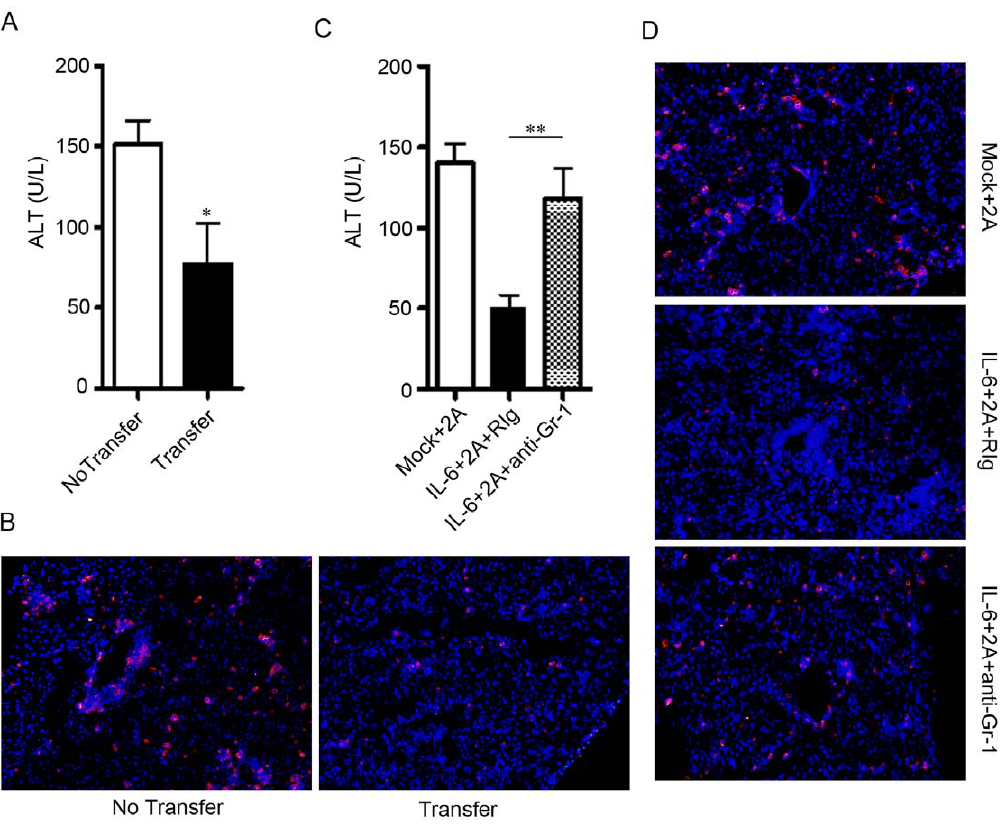
Figure 5. Gr-1 + CD11b + myeloid cells mediate the liver protective effect of IL-6. (A) C57BL/6 mice were i.p. injected with 100 m g 2A at day 0, and then adoptively transferred with 1 6 10 7 CD11b + intrahepatic leukocytes from IL-6 treated mice or PBS as control at day 5. ALT levels in serum were detected at day 10. CD11b + cells purification procedure was described in Materials and Methods . Representative data from 2 independent experiments with at least 3 mice per group was shown. (B) Detection of CD8 + T cells (red color) in liver sections. Mice were treated as in (A). DAPI counterstaining was used to detect nuclei. (C) C57BL/6 mice were hydrodynamic injected with pcDNA-IL6 plasmid or mock plasmid at day 0. At day 2, they were i.p. injected with 2A antibody. 300 m g of anti-Gr-1 antibody or control Rat IgG were given at day 2, 4, 6, 9, and ALT levels in serum were detected at day 12. (D) Detection of CD8 T + cells (red color) in liver sections. Mice were treated as in (C). DAPI counterstaining was used to detect nuclei. Representative data from 2 independent experiments with at least 3 mice per group is shown. *P , 0.05, **P , 0.01 in comparison with control groups or groups as indicated. as in Figure 2. At day12, the spleen cells were harvest and BrdU incorporation was analyzed by FACS. Percentage of BrdU + CD8 + T cells in total CD8 + T cell in spleen and the number of BrdU + CD8 + T cells were showed. Representative data from 2 independent experiments with at least 3 mice per group is shown. (TIF) Figure S4 Gr1 + CD11b + myeloid cells are dramatically increased in the spleen. C57BL/6 mice were treated as in Figure 3. At day 12 the spleen cells were isolated for FACS analysis. (A) Representative staining of Gr-1 + CD11b + cells in the spleen. (B) The percentage of Gr-1 + CD11b + cells in spleen cells. (C) The number of CD4 + T cells, CD8 + T cells, NKT cells, NK cells, B cells, and Gr-1 + CD11b + cells in the spleen of 2A treated mice. Graphs represent the mean (SD) of 3–5 mice each group. Three independent experiments were performed with similar results. *P , 0.05, **P , 0.01, ***P , 0.001 in comparison with control groups or groups as indicated. Figure S5 Adoptive transfer and depletion of MDSCs in vivo. (A) C57BL/6 mice were treated as in Figure 5A. At day 10